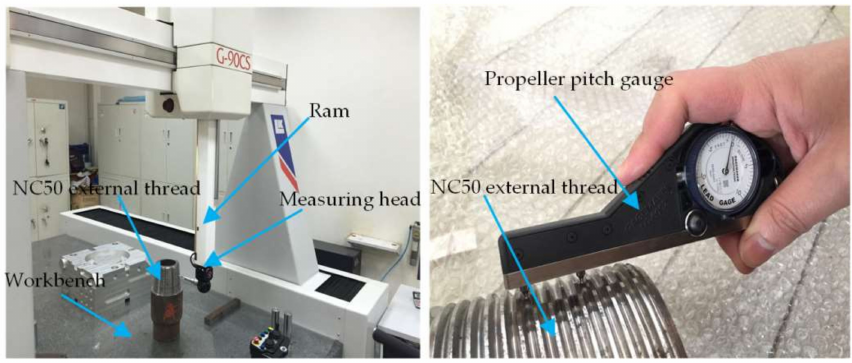
Figure 17. Measuring experiment for comparison.